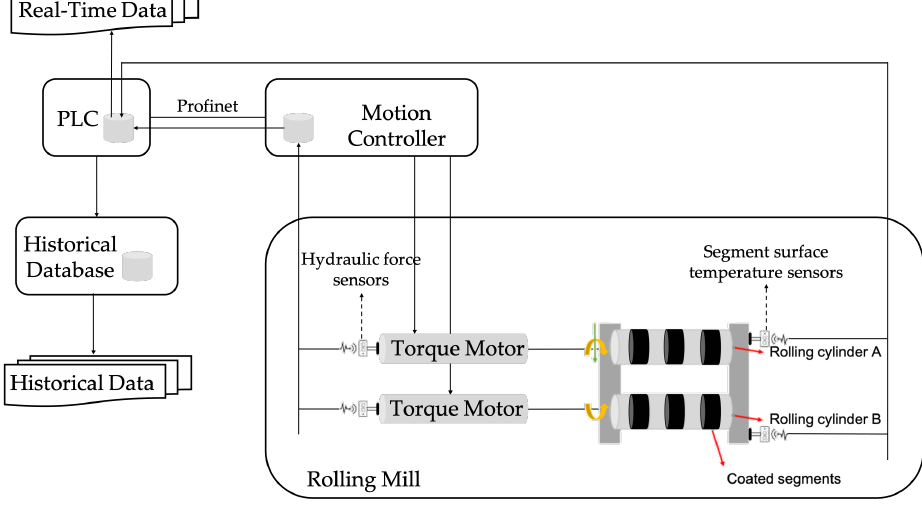
Figure 3. Rolling mill